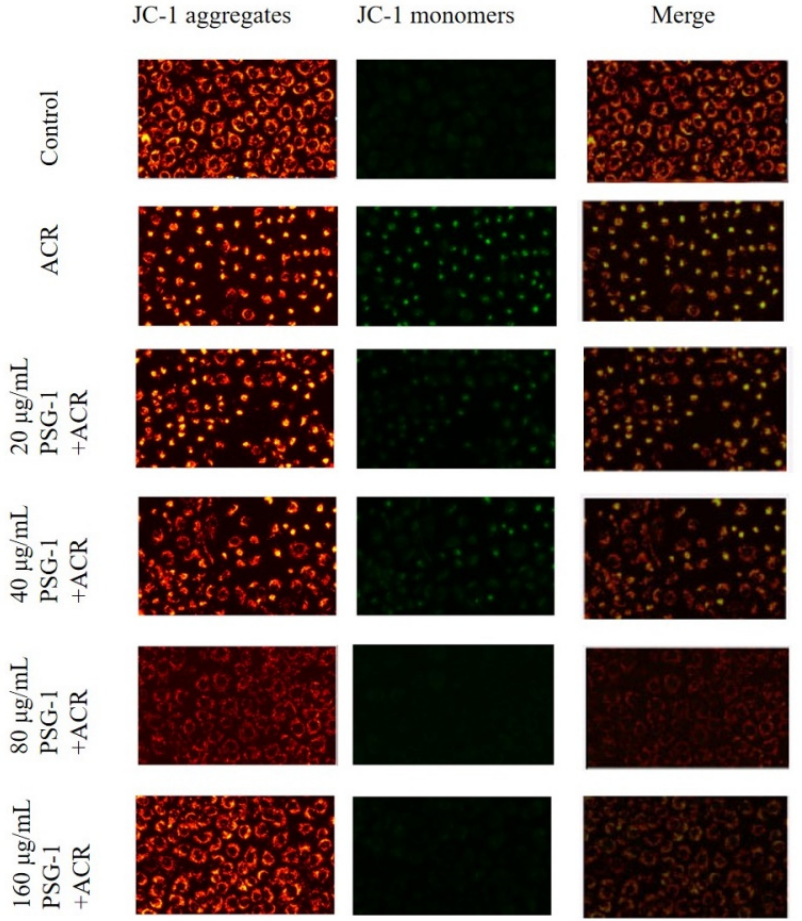
Figure 6. PSG-1attenuatedacrolein-inducedMMPreduction. Figure 6. PSG-1 attenuated acrolein-induced MMP reduction. MMP was detected by fluorescence microscopy.